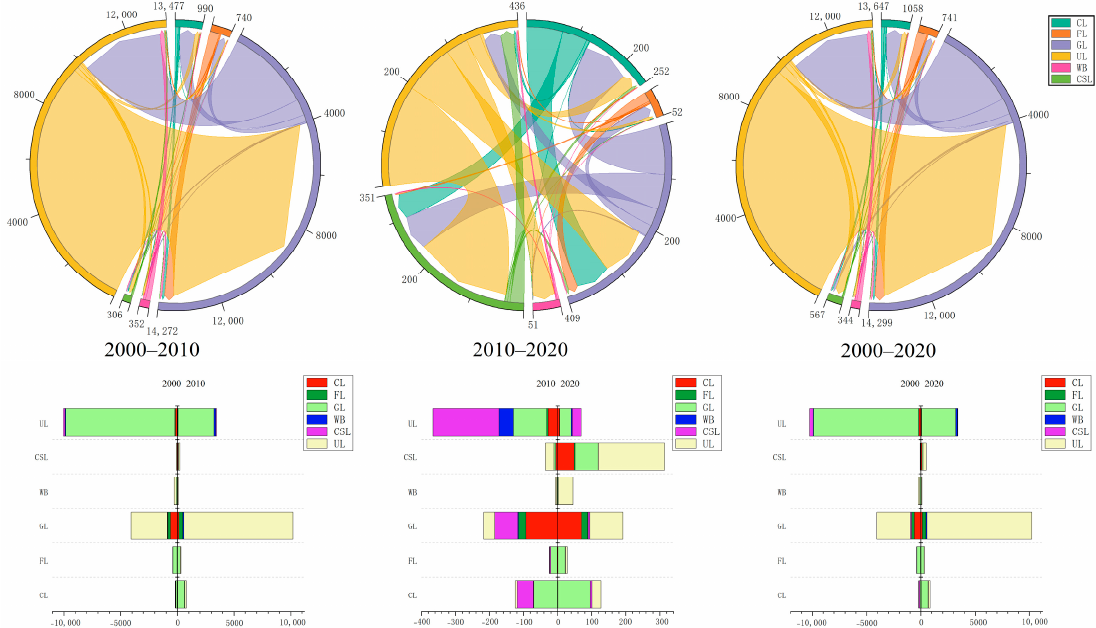
Figure 3. The transition among each LUC type. CL, FL, CSL, WB, GL and UL are cropland, forest land, construction land, water body, grassland and unused land, respectively.